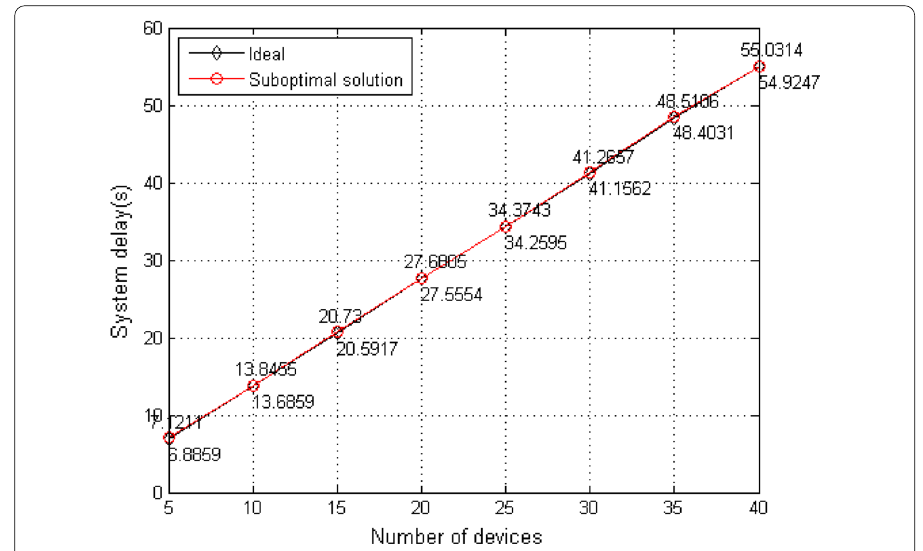
Fig. 4 Comparison of solutions to